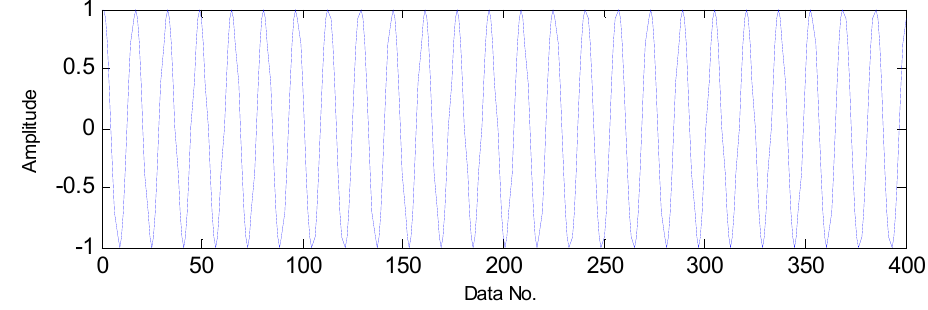
Figure 5. The simulated harmonic signal.